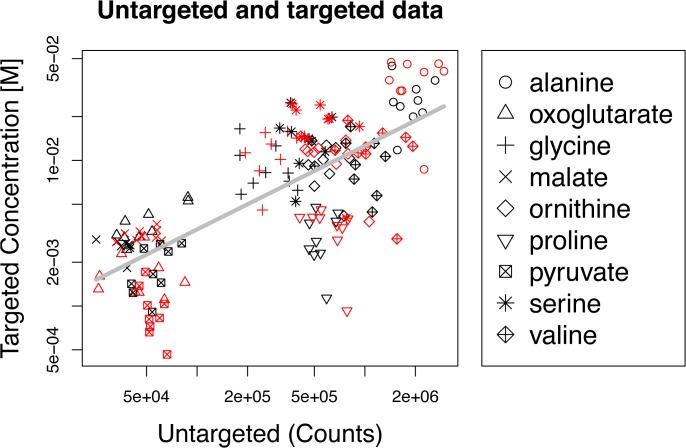
Correlation of untargeted and targeted metabolite measurements.Untargeted metabolite levels are well correlated with targeted measurements of amino acids and organic acids. Each data point on the graph corresponds to a timepoint, metabolite, and strain (n = 162; 2 strains, 9 metabolites, 9 timepoints). Each metabolite is shown using a different symbol (see legend). Detections in the Δura3 strain are shown in black and detections in the ΔtrmB strain are shown in red. Log-log linear regression of targeted and untargeted concentrations is shown in grey.